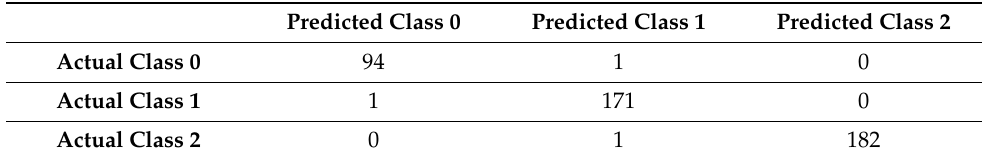
Table 11. Confusion matrix of settlement severity classification from the recurrent neural network (RNN)